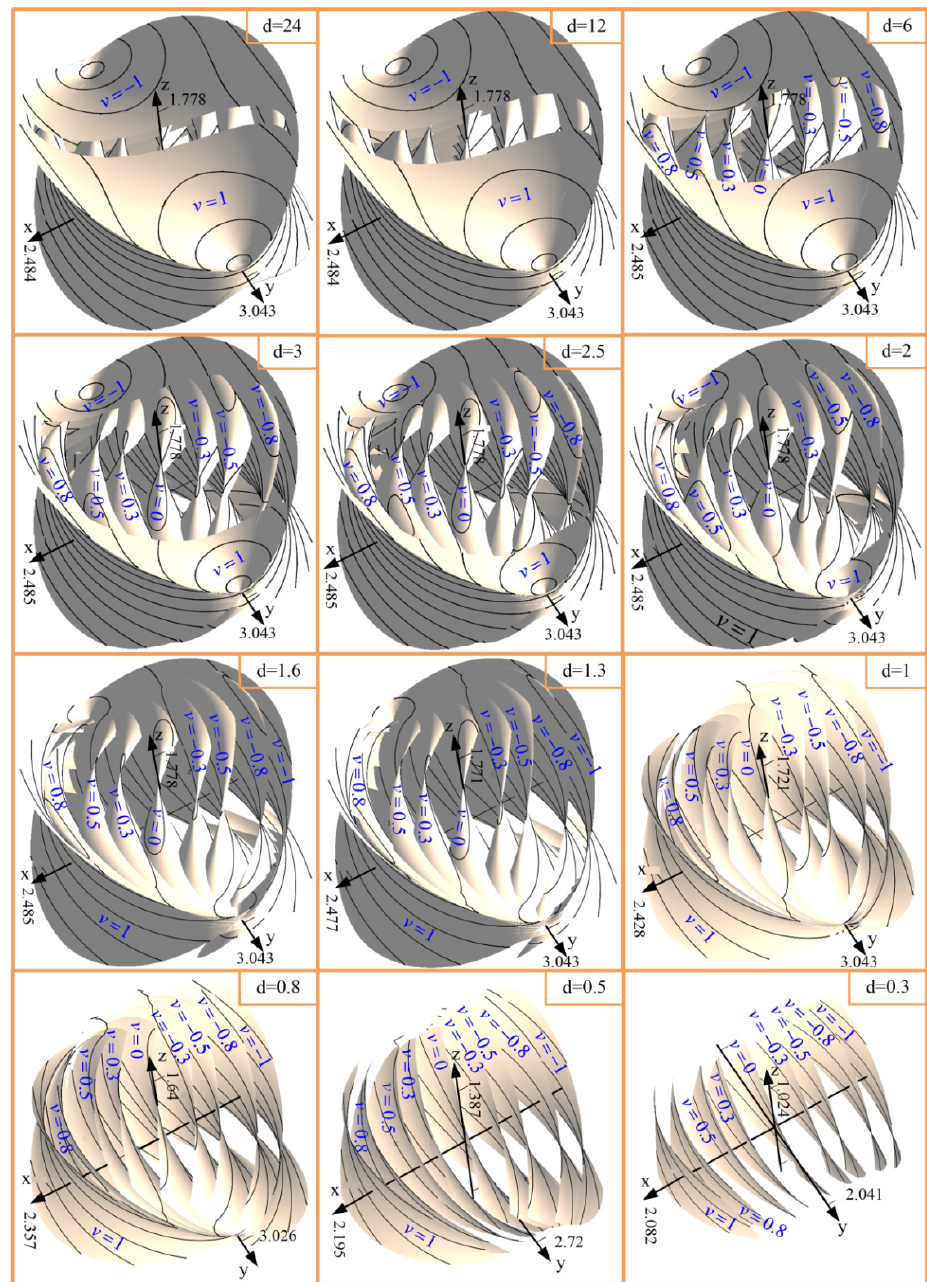
Figure 6. The relative location of the five evolutionary surfaces.